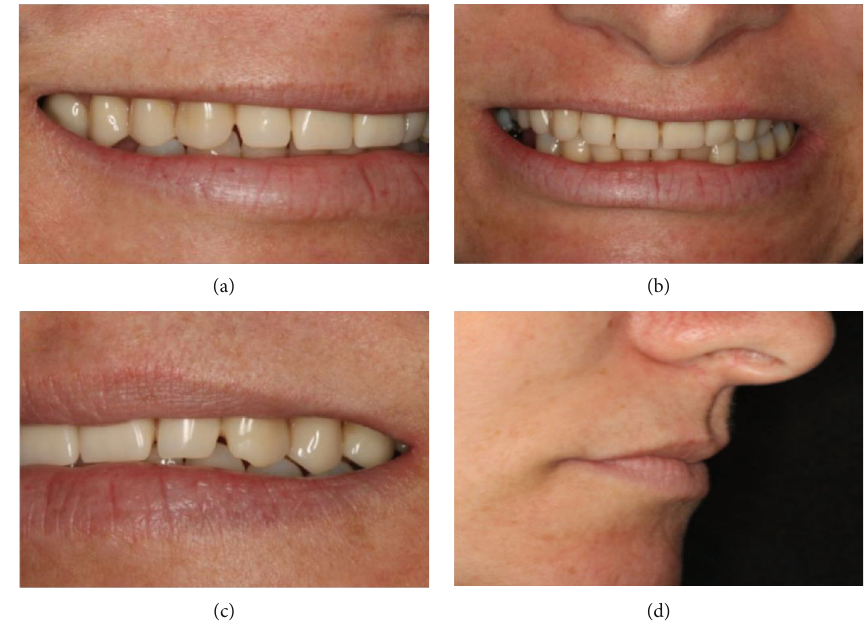
Figure 1: Clinical images of the patient ’ s smile.